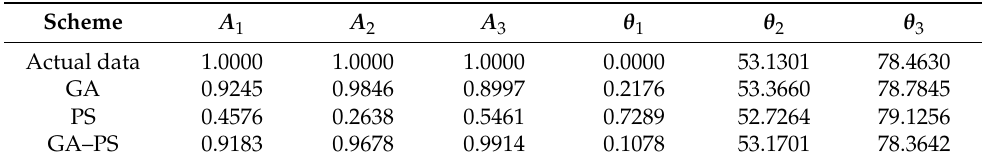
Table 4. Comparison of DOAs achieved using GA, PS, and GA–PS.